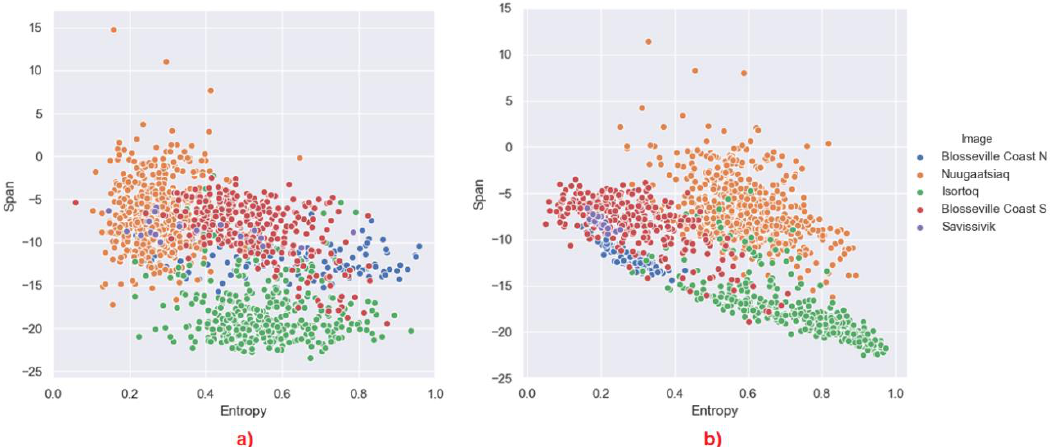
Figure 10. ( a ) Iceberg entropy, span plot 5 × 5 window, ( b ) 11 × 11 window. Note the negative values for span. Entropy values are between 0 and 1. Colour legend indicates each image and each dot is an iceberg.